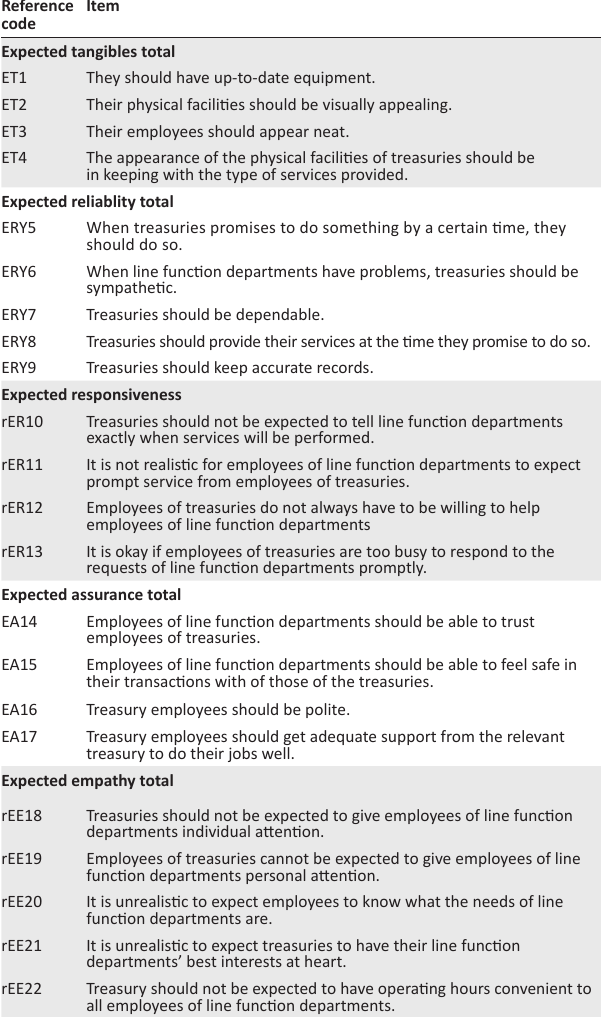
TABLE 1a: Measuring instrument used in the study. Service expectations (Part A).